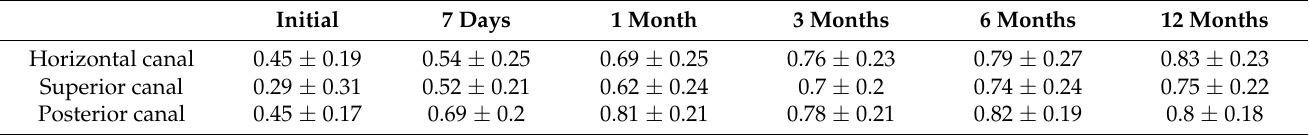
Table 3. Mean values for the horizontal, superior, and posterior canal at each follow up.